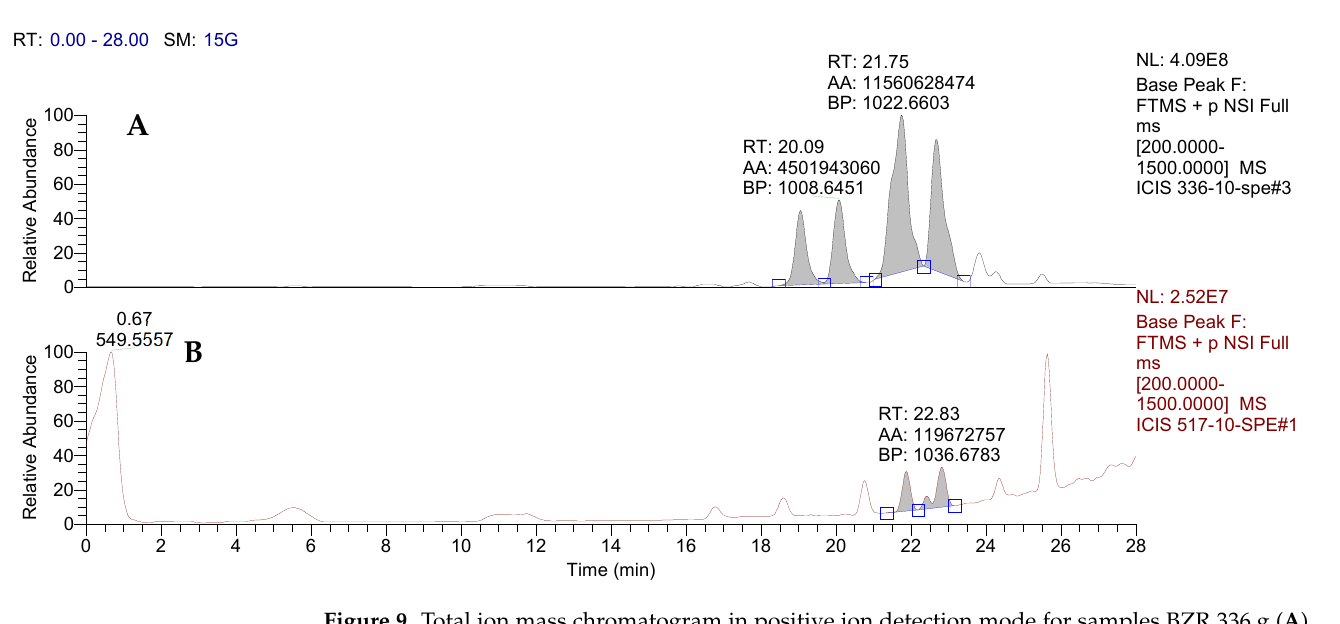
Figure 9. Total ion mass chromatogram in positive ion detection mode for samples BZR 336 g ( A ) and BZR 517 ( B ).